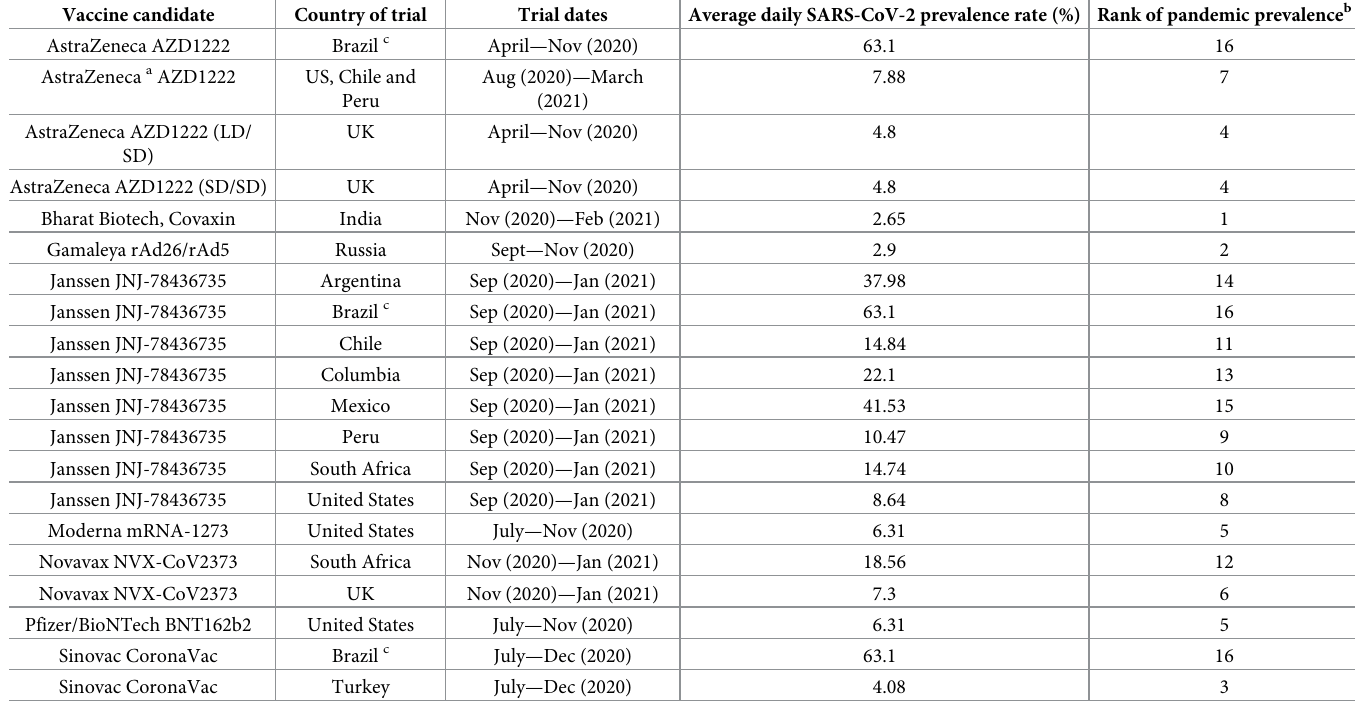
Table 2. Prevalence of the SARS-CoV-2 pandemic associated with each